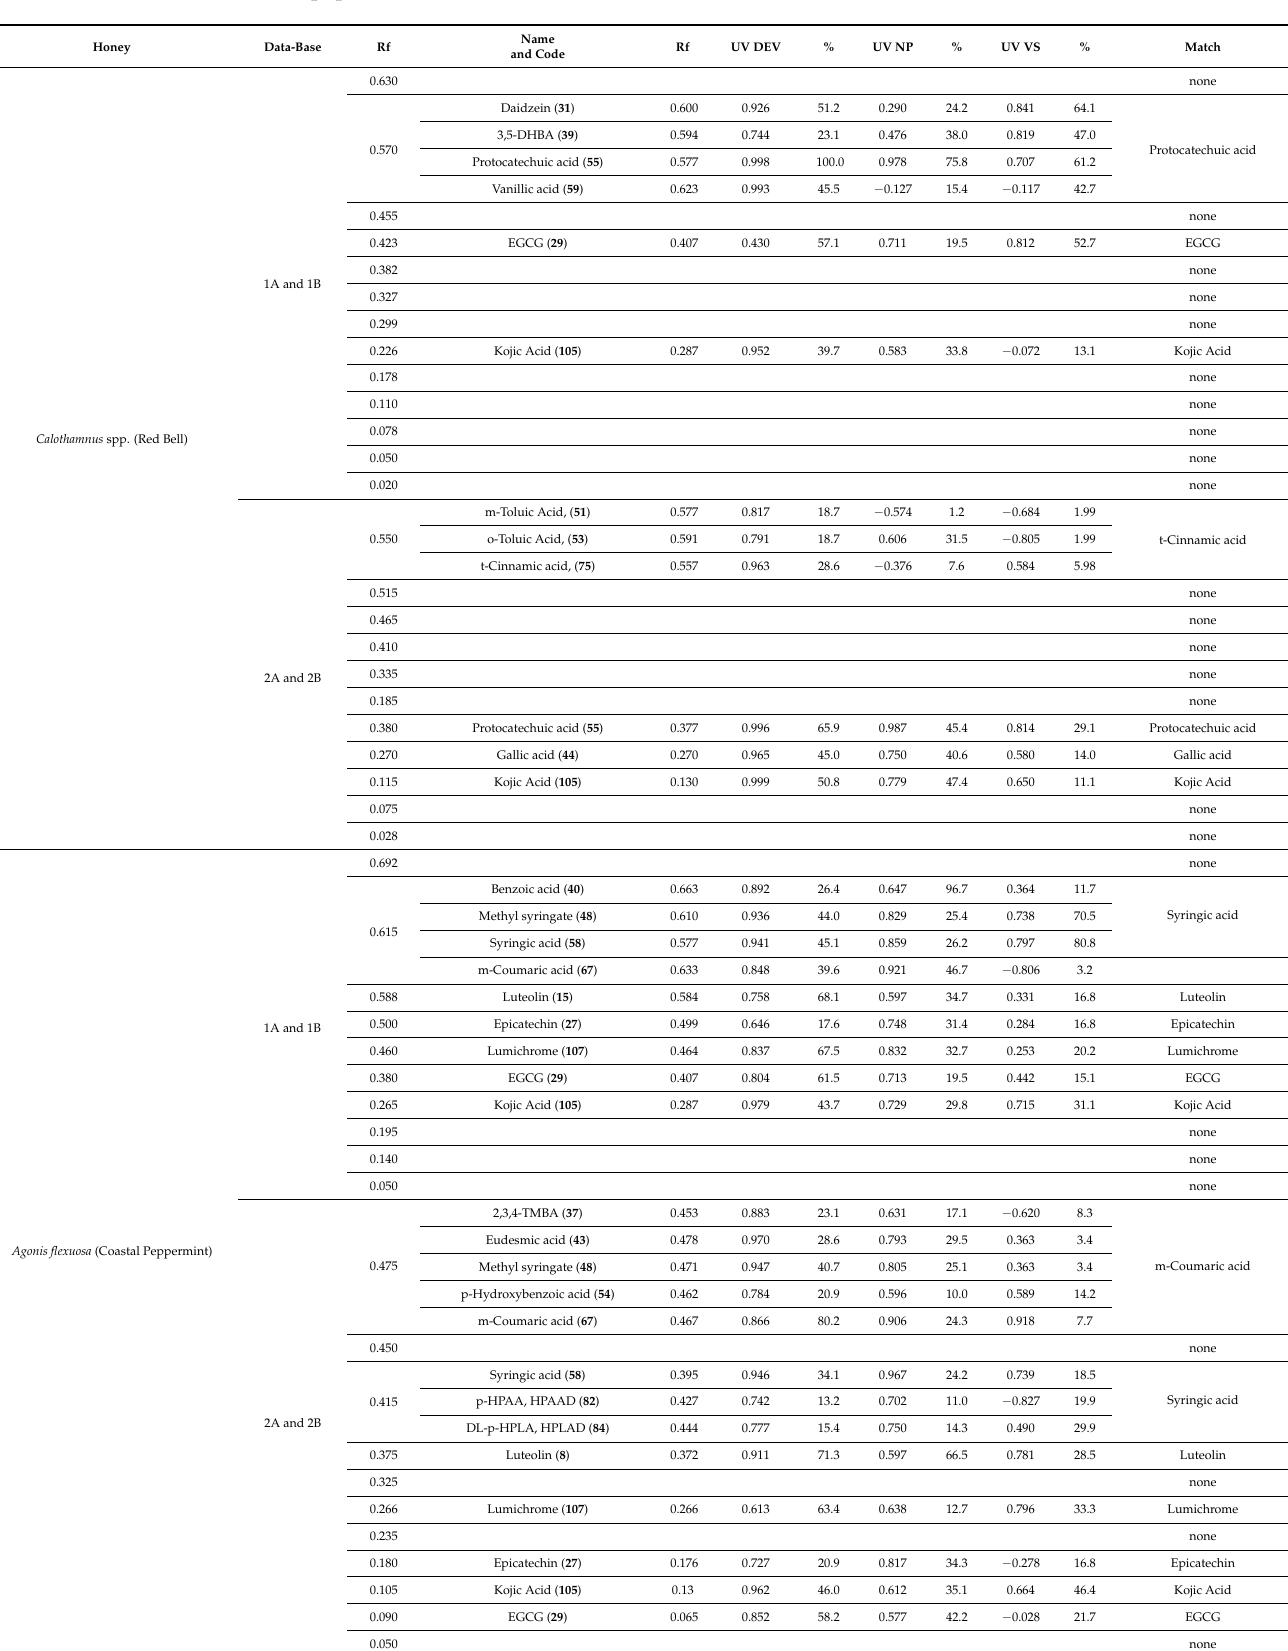
Table 5. Match compounds, correlations, and % similarity of match compounds identified in Western Australian honey (Note: Compound codes are based on a previously published phenolic database paper